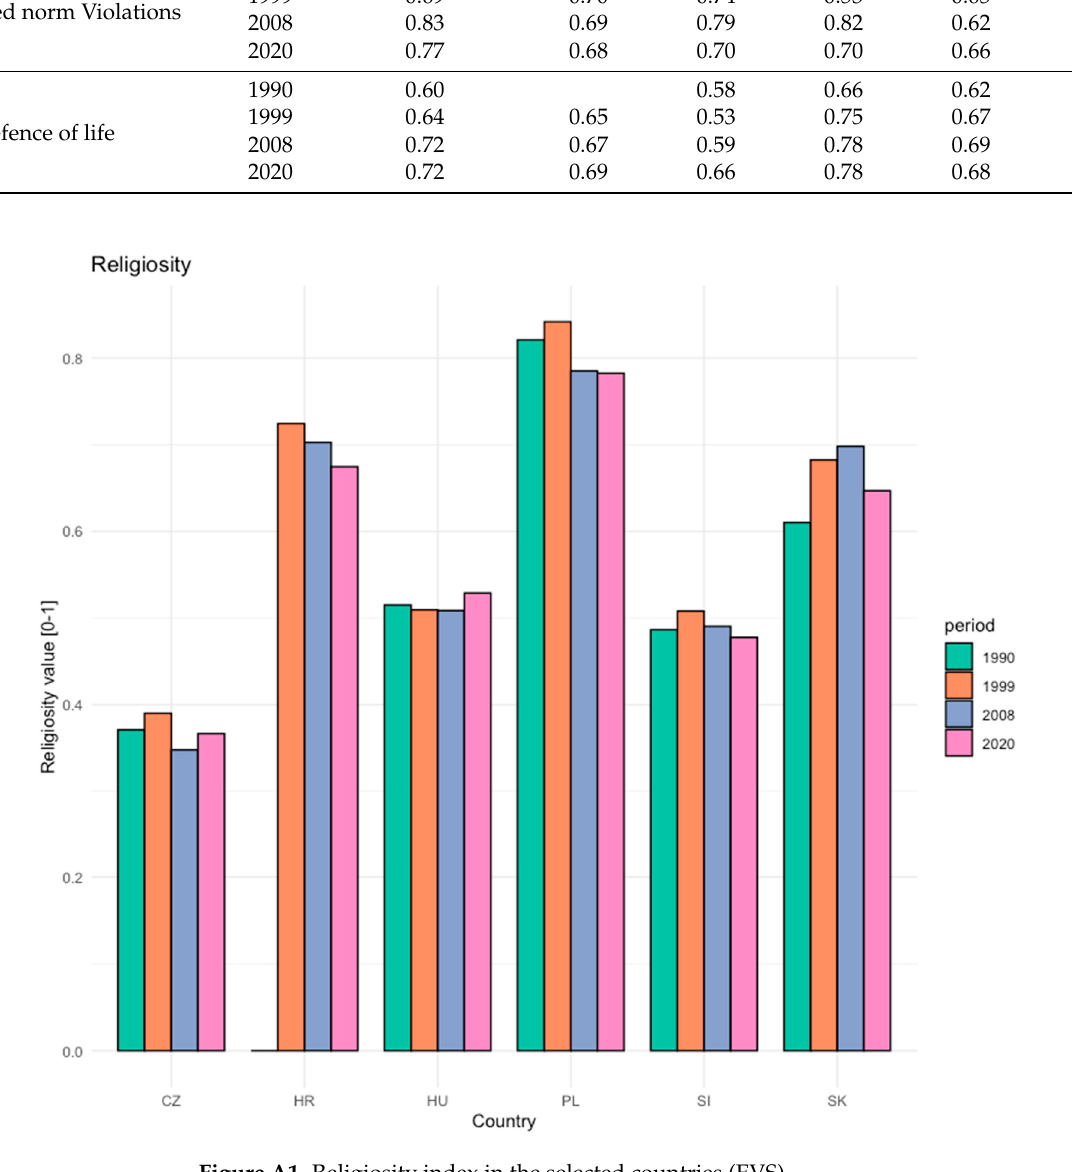
Figure A1. Religiosity index in the selected countries (EVS).